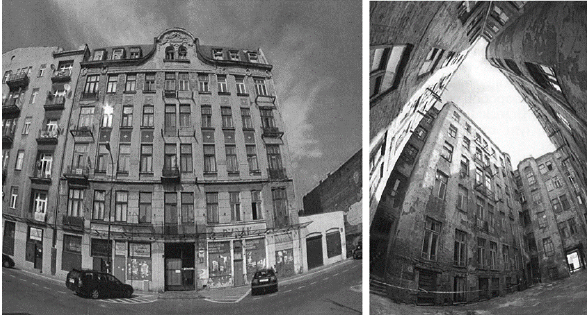
Figure 1: View of the facade of the tenement house and the court- yard elevations